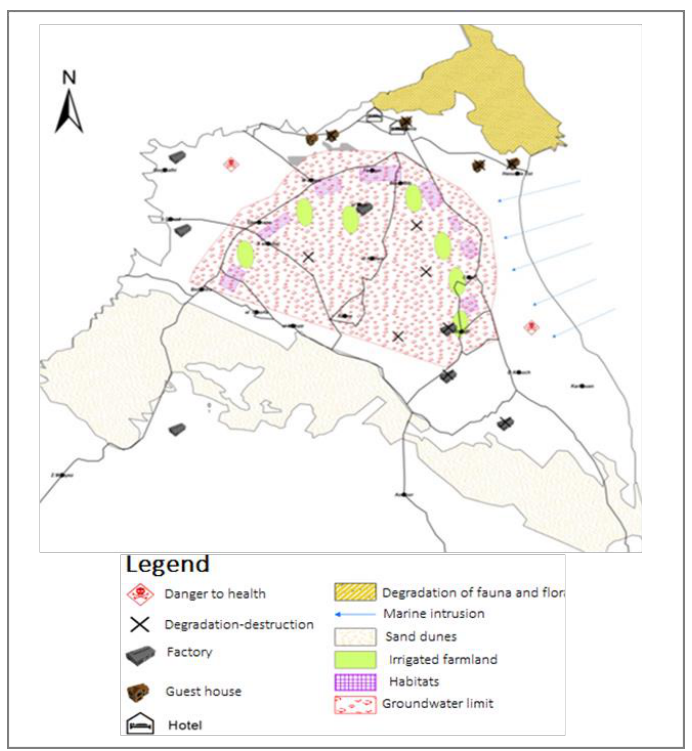
Figure 5. An example of scenario of change: " what legacy have we left? The future of El Haouaria Figure 6. An example of scenario of change: “what legacy have we left? The future of El Haouaria without improvement actions " drawn by the second group. without improvement actions” drawn by the second